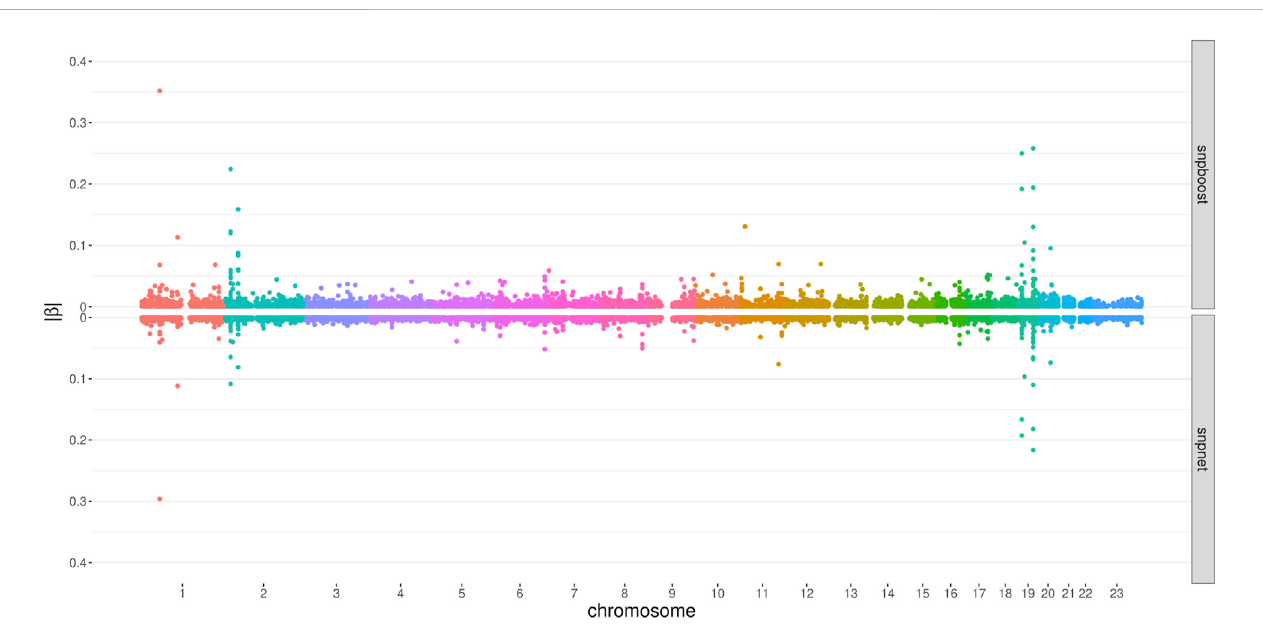
FIGURE 6 Absolute values of coef fi cient estimates for PRS models for LDL-cholesterol derived by boosting (snpboost) and lasso (snpnet) in dependence of the genomic position of the